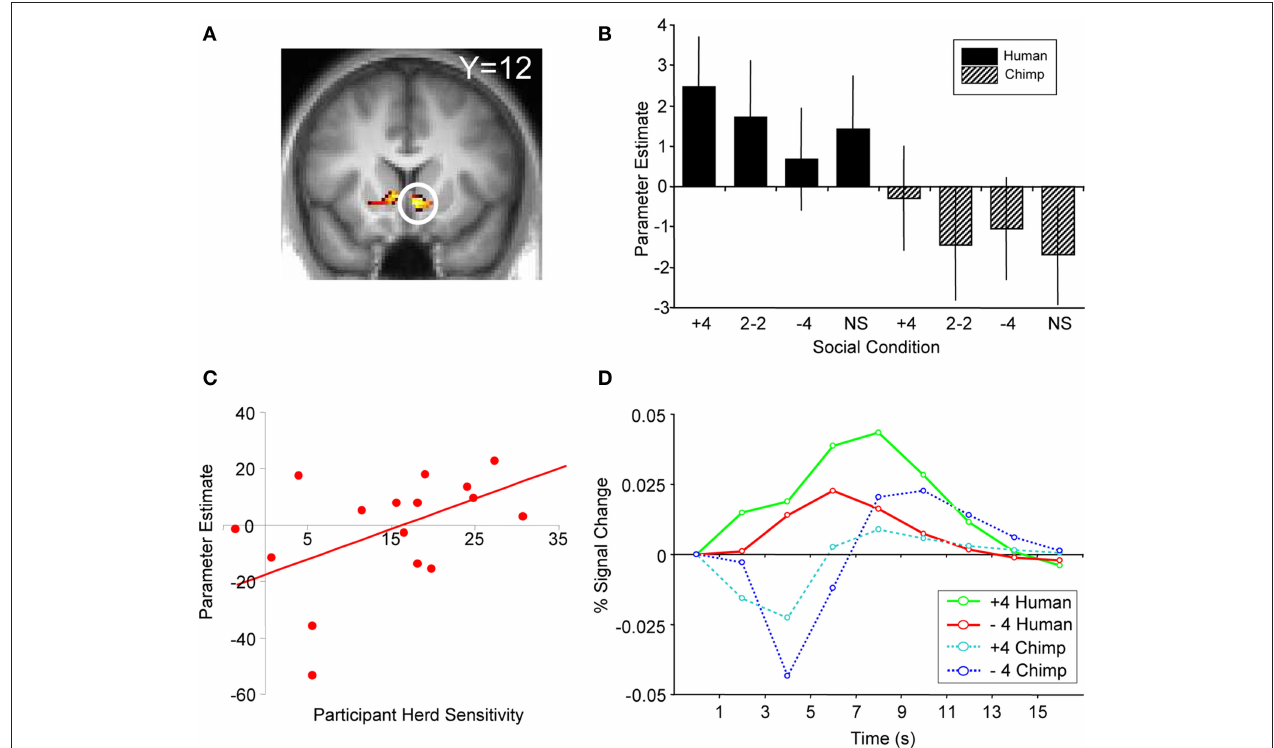
significantly with the subjective degree of herd influence (Pearson’s r = 0.544, p = 0.024; Kendall tau = 0.356, p = 0.048). (C) Comparison of second-level parameter estimates (betas ) for each social condition from the same GLM analysis and region of activation shown in (A) . (D) Adjusted BOLD time courses in right ventral striatum time-locked to the presentation of social information. The behavioral relationship is evident between 3 and 7 s after the onset of social